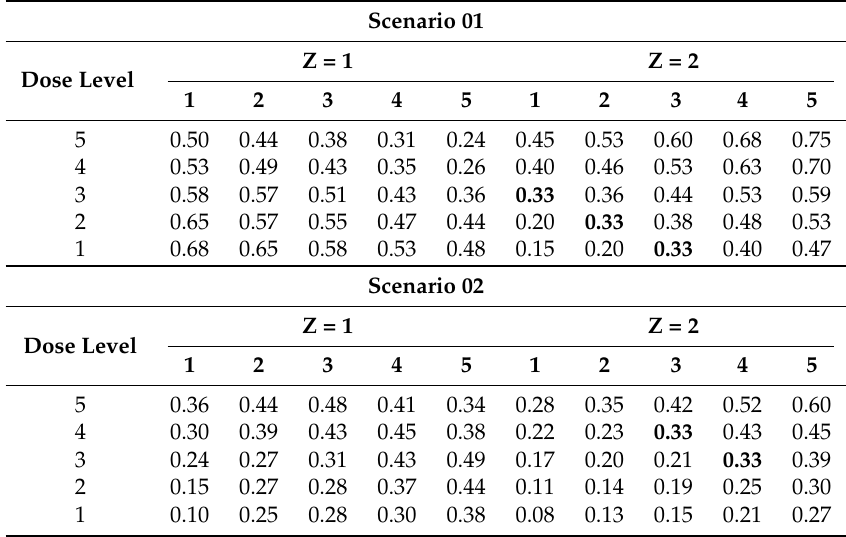
Table 2. A selected dose limiting toxicity scenario with θ = 0.33 for Z = 1,2 considering discrete dose combinations. True MTDs are shown in